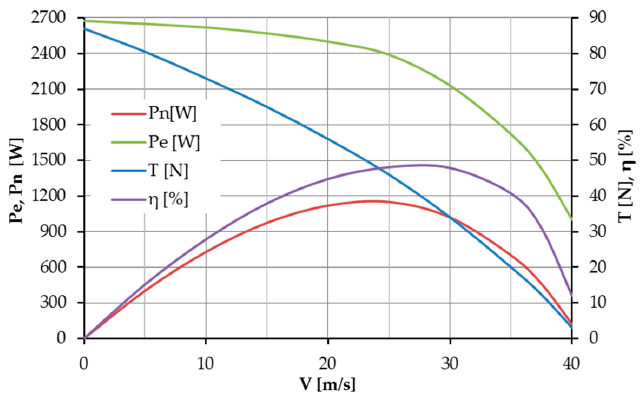
Figure 22. The ducted fan propulsion performance: P N —effective power, P e —motor electric power, η —total efficiency, T —thrust.